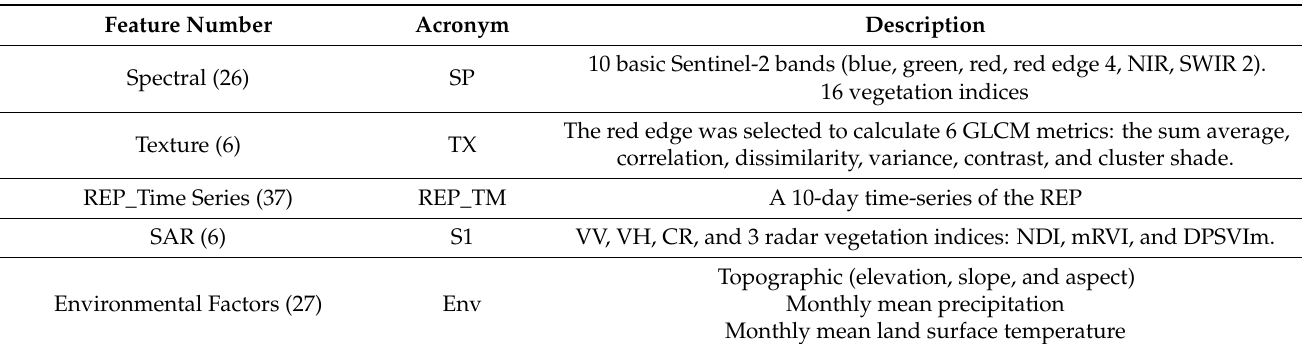
Table 1. Features used in this